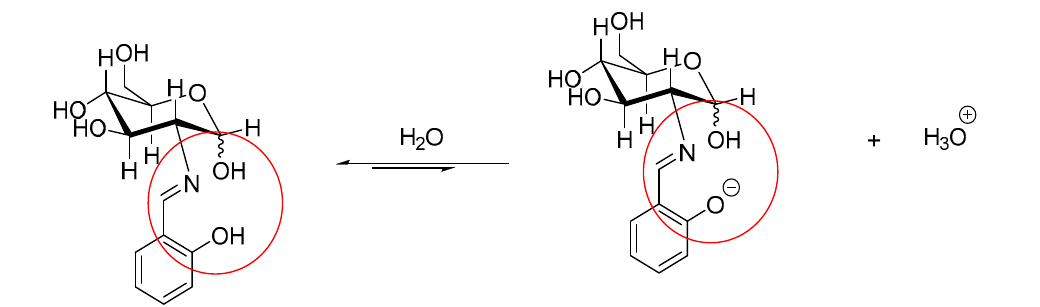
Scheme 2. Dissociation of the phenolic Schiff base in water polar medium.